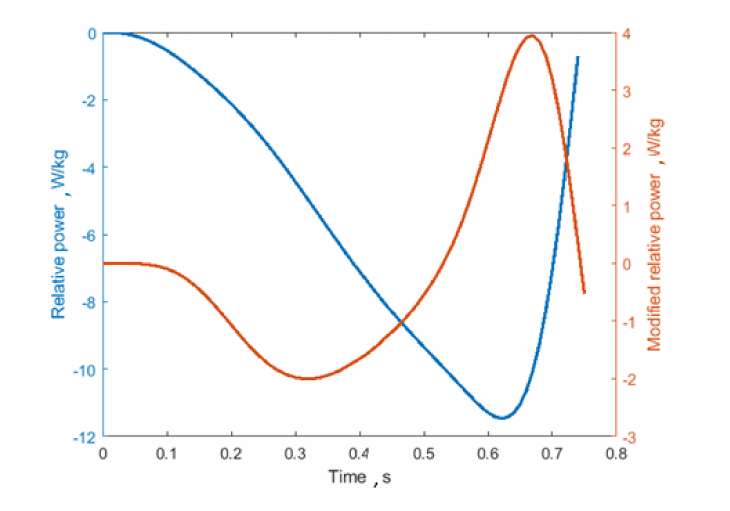
Figure 3. Difference between relative eccentric power (in blue) and modified relative eccentric power (in orange), from which the aforementioned parameters were